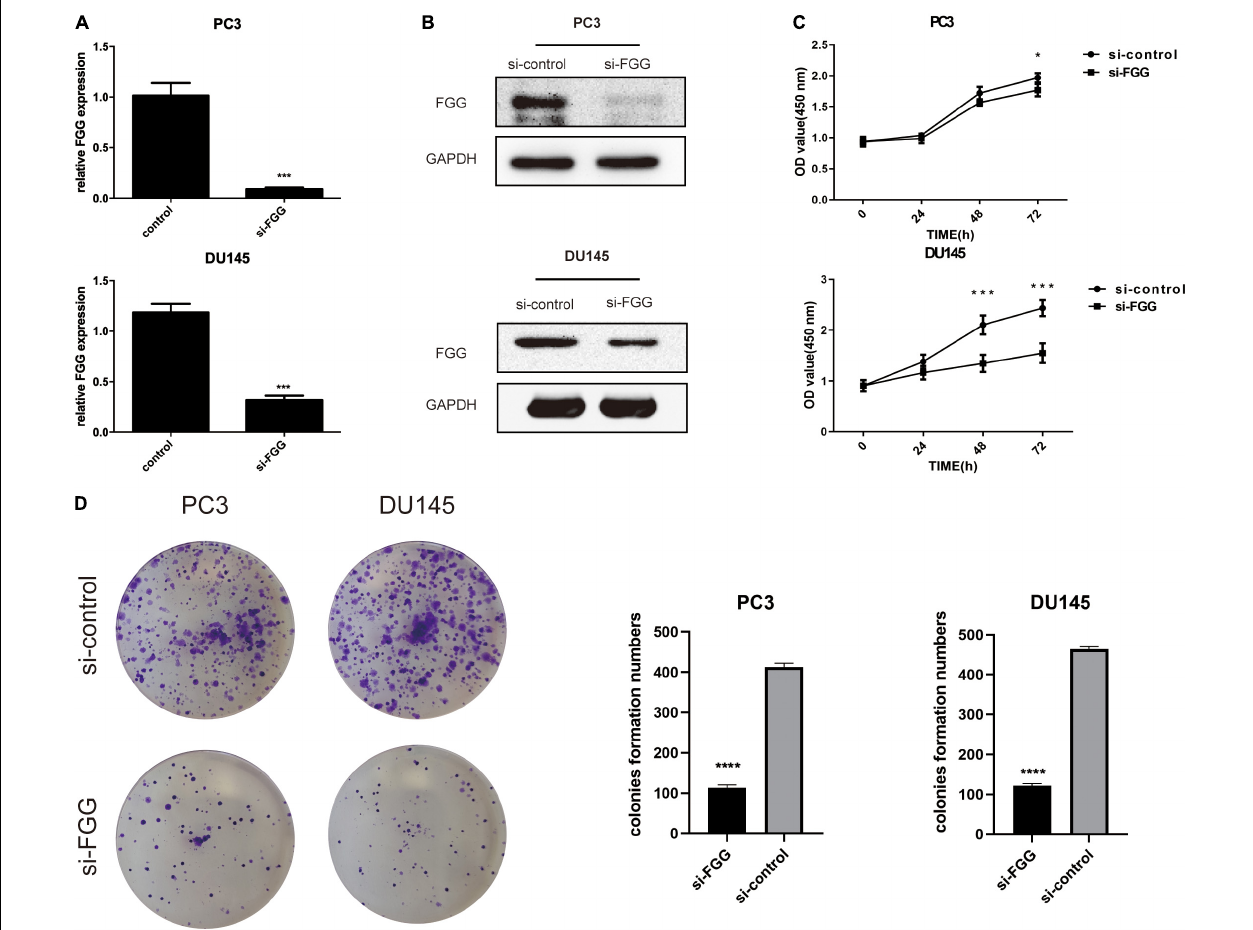
FIGURE 3 | FGG knockdown reduces the proliferation capabilities of PCa cells. (A) qRT-PCR and (B) western blot analyses indicate that si-FGG significantly suppressed FGG mRNA and protein expression. (C) CCK8 experiments demonstrate that FGG knockdown decreased cell proliferation in PC3 and DU145 cells compared to control cells. (D) Colony formation assays shows that FGG knockdown significantly decreased cell proliferation in PC3 and DU145 cells. * p < 0.05, *** p < 0.001, **** p <